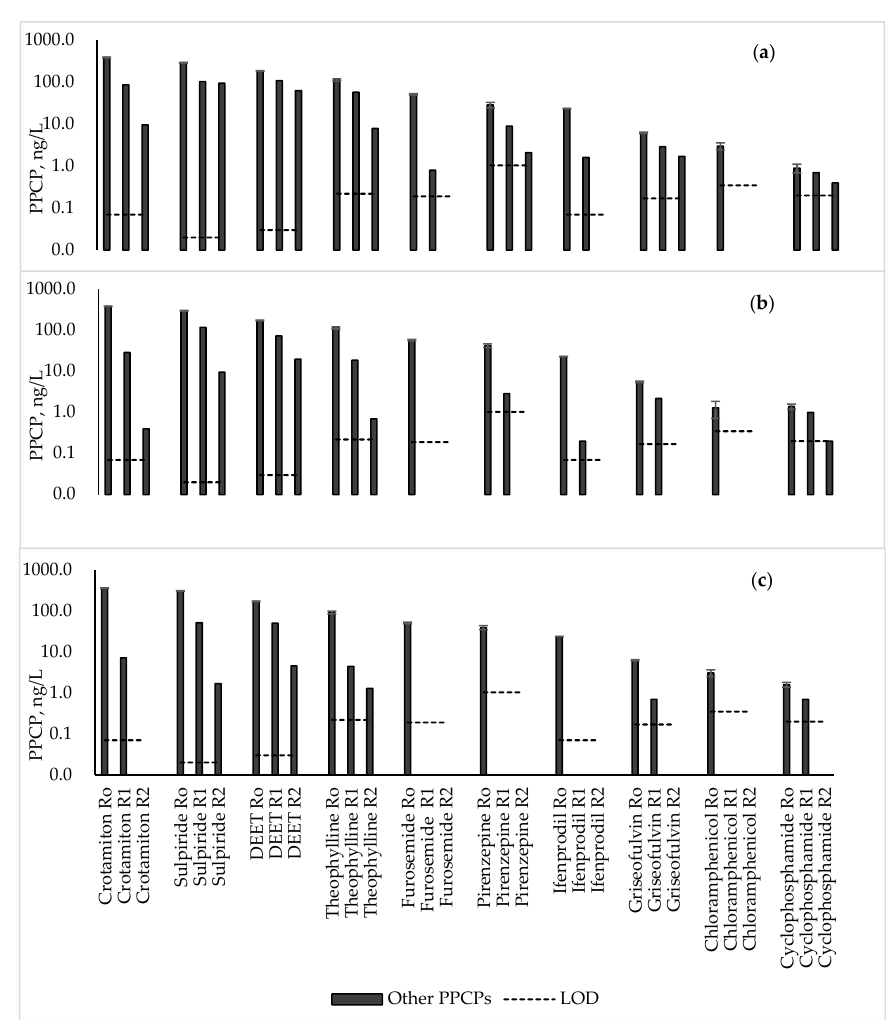
Figure 8. Concentrations of 10 other PPCPs in the feed secondary effluent (R o ) and effluent of the R 1 and R 2 reactors at the O 3 doses of: ( a ) 1 and 2 mg L − 1 , respectively, in Run 1; ( b ) 2 and 4 mg L − 1 , respectively, in Run 2; and ( c ) 3 and 6 mg L − 1 , respectively, in Run 3.